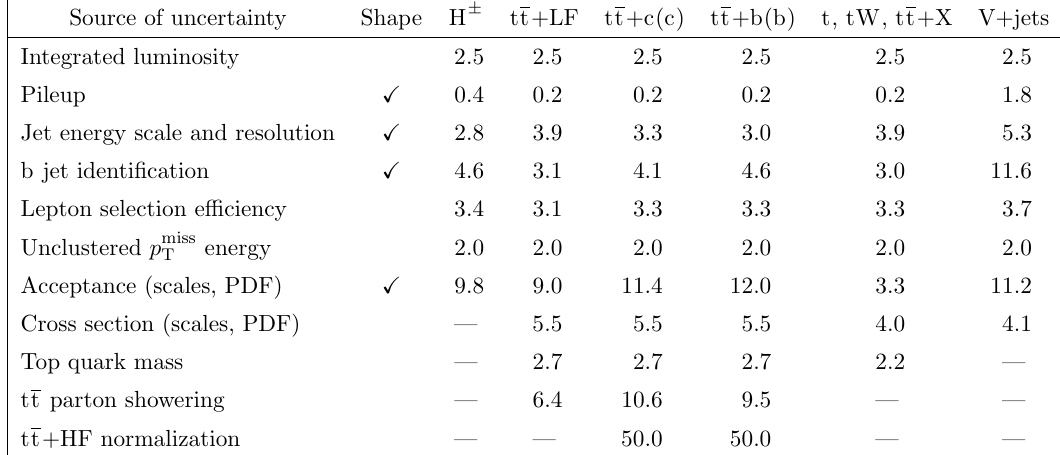
Table 2 . E(cid:11)ects of the systematic uncertainties as the variation (in percent) of the event yields prior to the (cid:12)t to data, summed over all (cid:12)nal states and regions. The column Shape reports whether a given uncertainty is considered a shape uncertainty or a rate